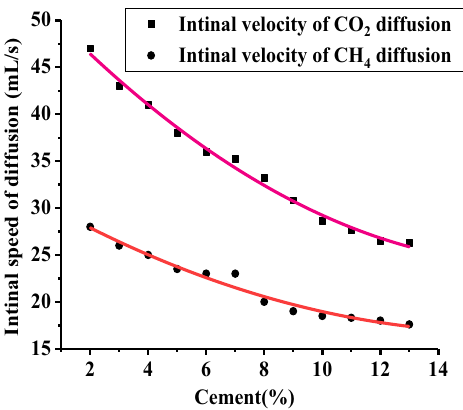
Fig. 14 Initial velocity of CH 4 and CO 2 diffusion of similar